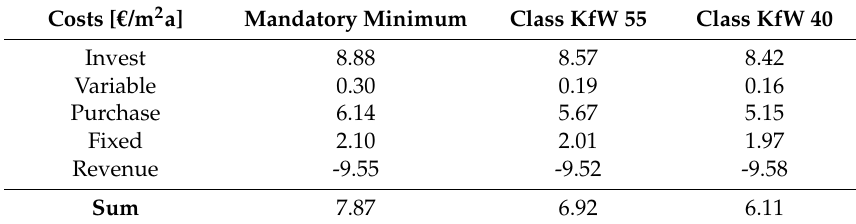
Table 10. Resulting annual costs of the energy systems for the considered energy efficiency classes.